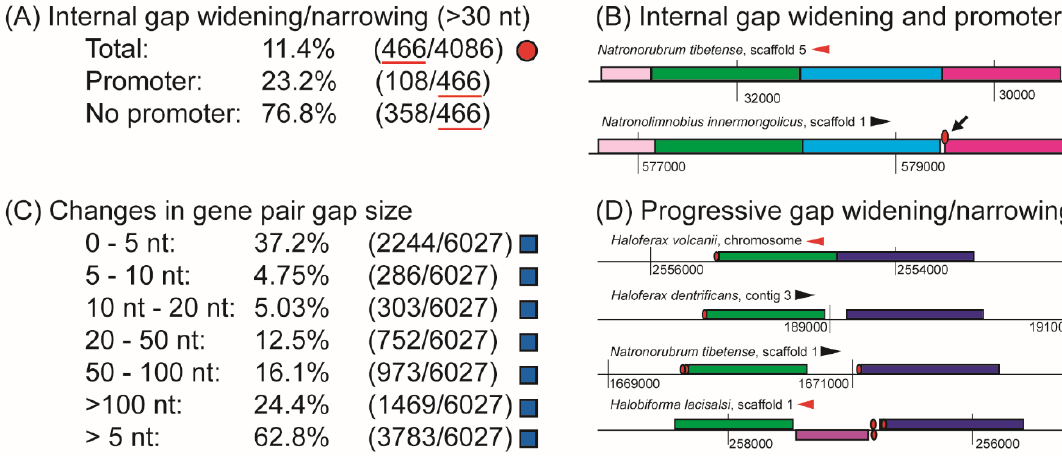
Figure 7. Modification by change in intergenic gap size. Intergenic gap sizes were assessed using two different query sets, based on identical content groups ( A , red circle), and co-occurring gene pairs ( C , blue square). Requiring that OLSs not vary in gene content, we determined that approximately 11% of these OLSs exhibited a difference in intergenic gap size of component genes of 30 nt or more ( A ). Of these (466, red underline), the appearance of an internal promoter coincided with the gap-widening event in approximately 23% (108/466) cases. ( B ) An example of such a combined internal gap widening and promoter appearance, where a pair of genes (blue and dark pink genes) transition from an intergenic gap size of 0 nt in Natronorubrum tibetense to an intergenic distance separation of 32 nucleotides in Natronolimnobius innermongolicus (black arrow indicates gap, promoter is shown elevated above intergenic gap for clarity). Light pink, green, blue and dark pink genes are acetylglutamate kinase, acetylornithine aminotransferase, acetylornithine deacetylase and ornithine carbamoyltransferase, respectively. Assessing only gene pairs that were identified to be collinear in an OLS in at least one organism, we found that changes in intergenic distance varied frequently ( C ). Certain cases appeared that may represent progressive deletion (or addition) of intervening sequence such as the example shown in ( D ), where the intergenic spacing between green (inosose isomerase) and dark blue genes (myo-inositol 2-dehydrogenase) increases progressively from Haloferax volcanii (3 nt), to to Haloferax denitrificans (174 nt), to Natronorubrum tibetense (442 nt), finally to Halobiforma lacisalsi ., where a gene in the opposite orientation appears. To interrogate this example further, we identified all examples where the genes with homology clusters 866 and 1119 were collinear and nearby, extracted intergenic gaps separating these genes, and performed a series of multiple alignments using the online ClustalW web tool [45], with default parameters. The results of multiple alignments of these intergenic can be found in supplementary information (File S10).